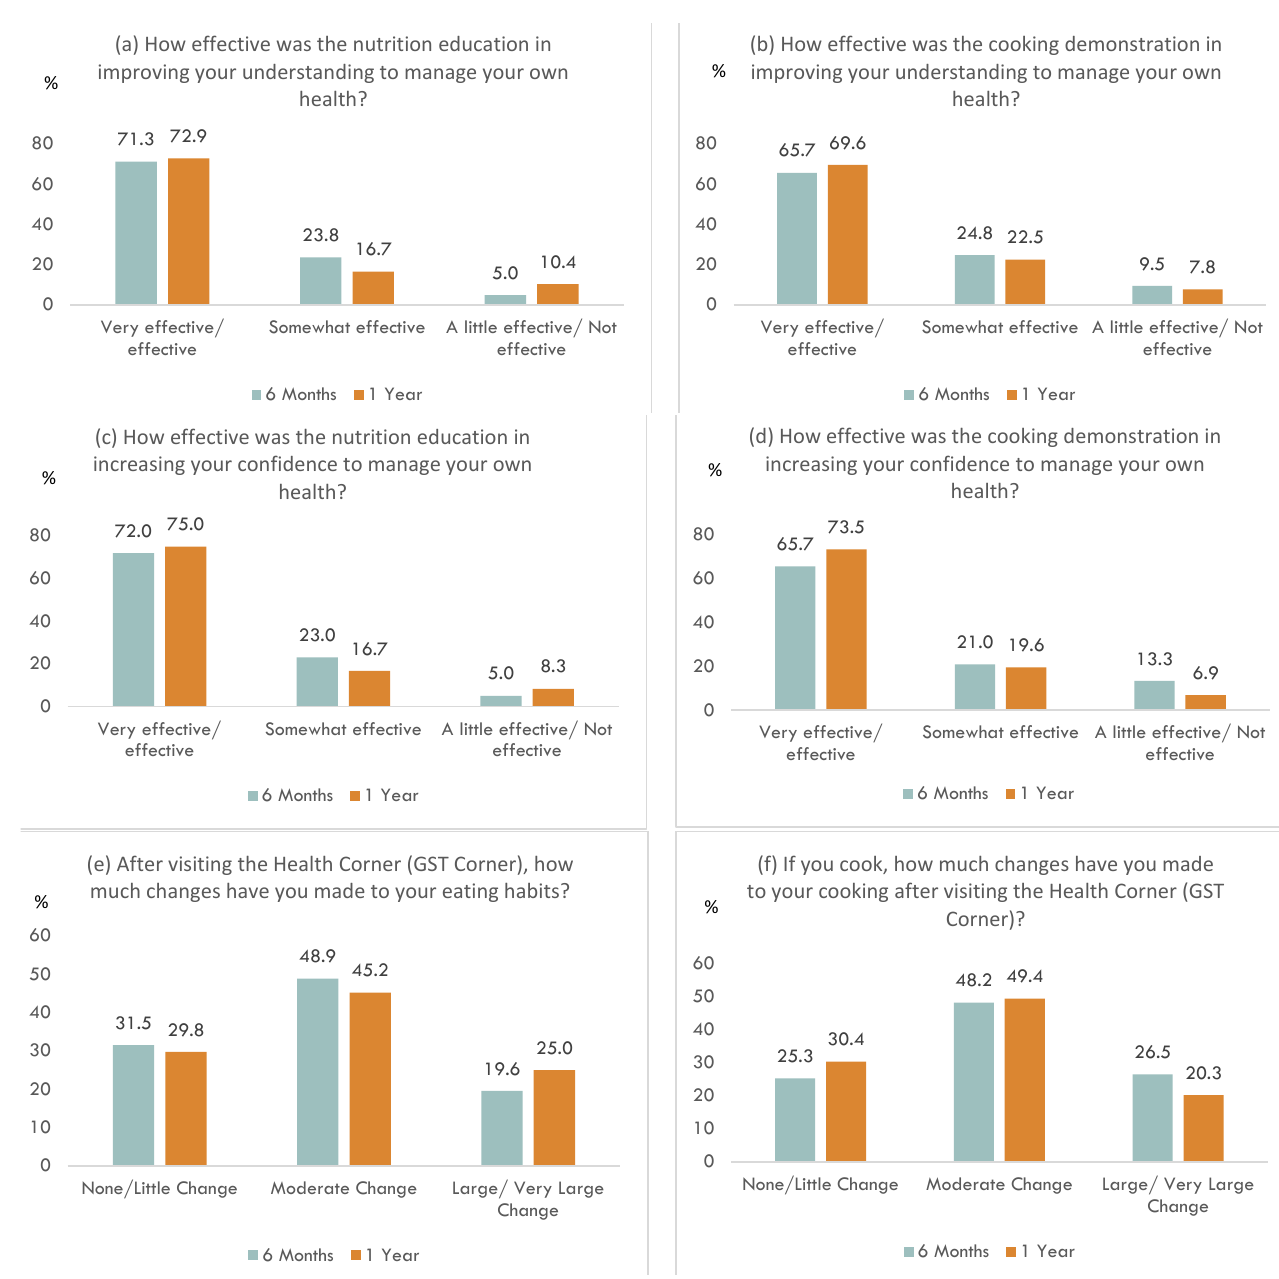
Figure 2. Results of the process evaluation in the intervention group; ( a ) Effectiveness of the nutri-